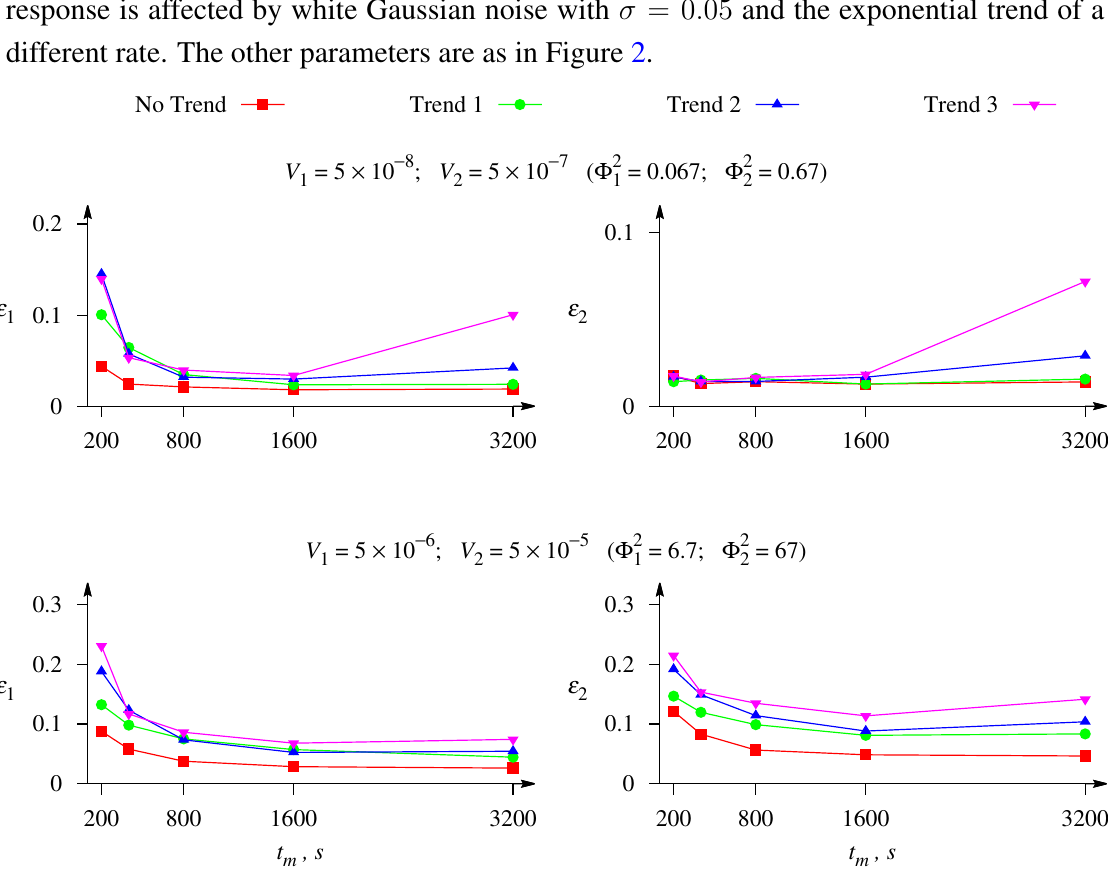
and ε , of the evaluation of the concentrations, c 1 2 and S , versus the duration, t , of the biosensor operation at different 1 2 m and V , and the Biot number β = 1 , when the 1 2